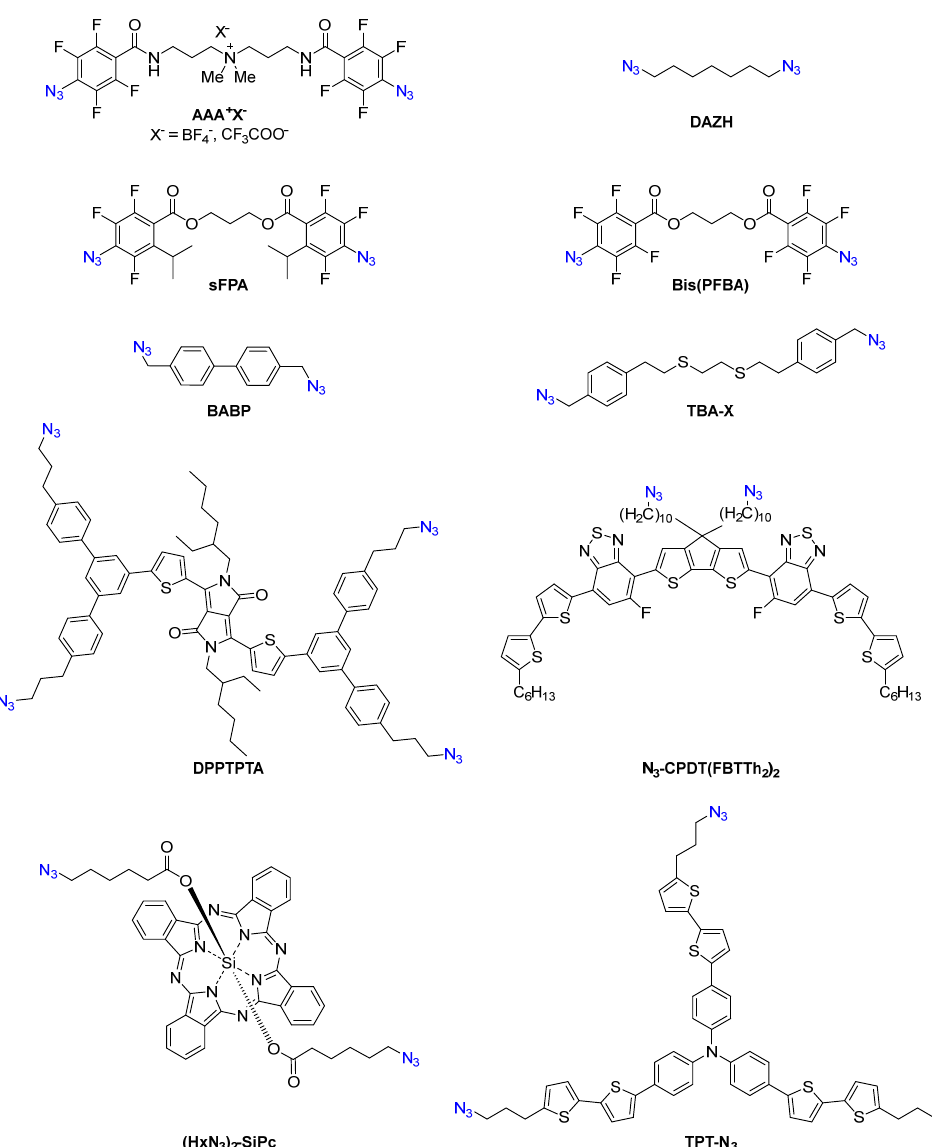
Figure 4. Bisazides used as crosslinkers in OPV: ionic 1,4 ‐ bis(perfluorophenyl azide) ( AAA + X ‐